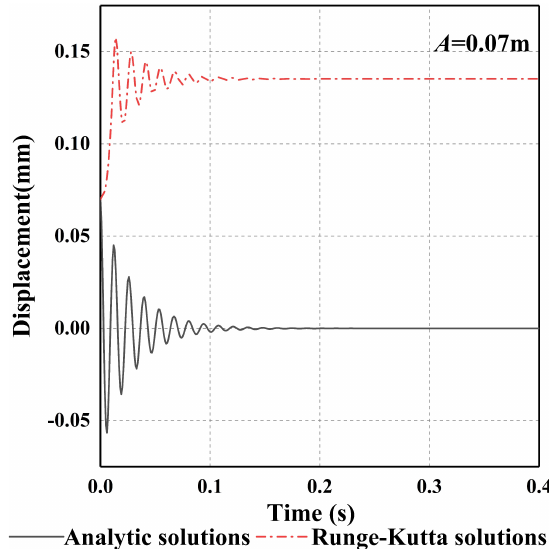
Figure 3: Comparison of analytical solution and numerical solution when A > 0.06 m